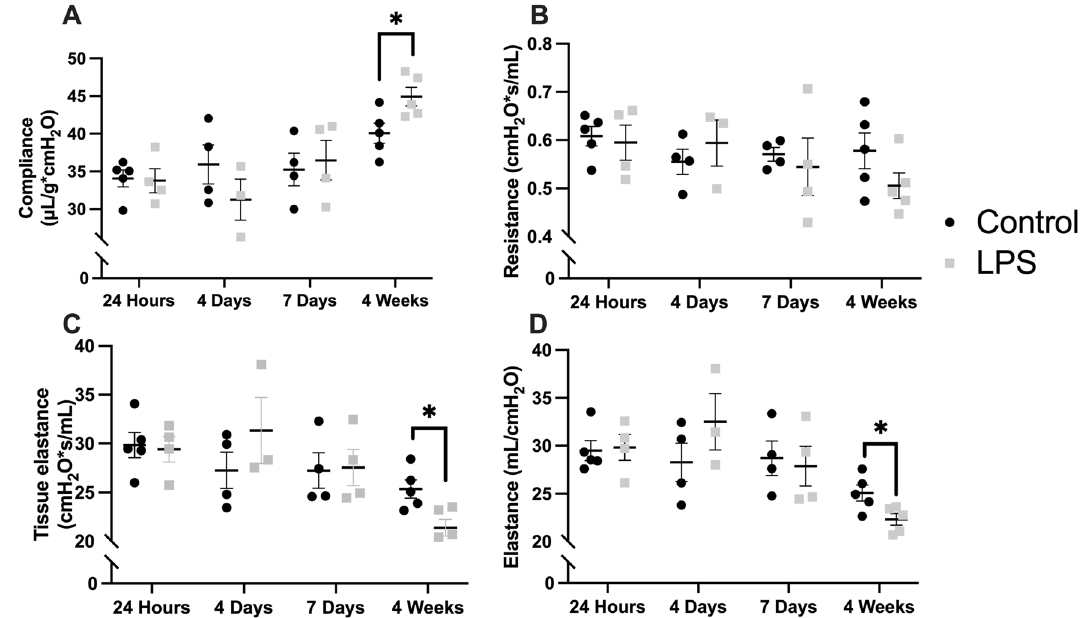
Figure 1. Pulmonary function testing. Lipopolysaccharide (LPS)-treated mice had similar pulmonary compliance compared to control mice at 24 h, 4 days, and 7 days after instillation but significantly increased compliance at the 4 week time point ( A) . There was no statistically significant difference in lung resistance (B) between the two groups at the various points. Tissue elastance (C) , and pulmonary elastance (D) , measures of lung elastic recoil, were also significantly lower in LPS-treated mice compared to controls at 4 weeks. Compliance was adjusted for mouse body weight. Statistical analysis of the experimental groups at each time point was performed with Student’s t-test. As the experiment is terminal, each time point is represented by a separate cohort. Results are expressed as mean ± SE. * P <